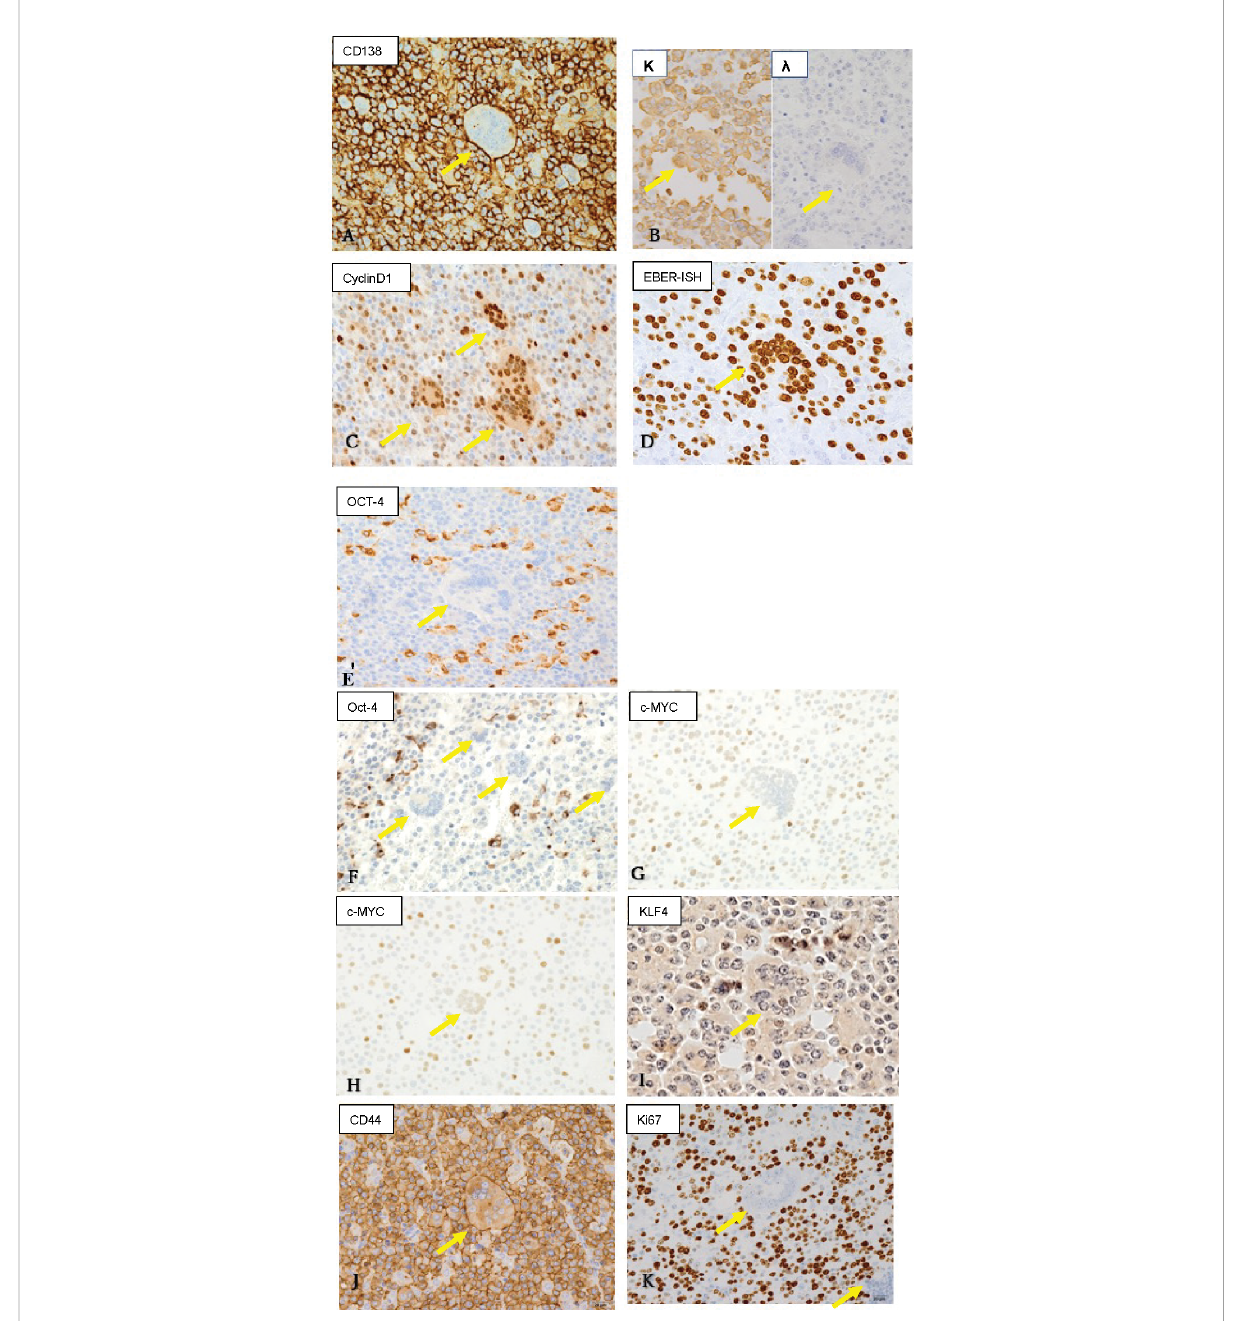
FIGURE 2 Immunohistochemistry and Epstein-Barr virus-encoded RNA (EBER) in-situ hybridization fi ndings (original magni fi cation ×40). Yellow arrows indicate multinucleated cells. Both multinucleated giant cells and mononuclear cells were positive for (A) CD138 (a plasma cell marker; membranous positive), (B) light chain restriction of k > l (suggesting monoclonality), (C) cyclin D1 (a marker for plasma cell myeloma), and (D) EBER (suggesting Epstein-Barr virus-associated neoplasm). (E) Both cell types were negative for CD68 (a histiocyte marker). (F) Mononuclear cells were positive, but multinuclear giant cells were negative for OCT4 (Yamanaka factor). (G, H) c-Myc (Yamanaka factor) expression was stronger in mononuclear than in multinucleated cells, and multinucleated cells with a larger number of nuclei (G) showed weaker positivity than those with a smaller number of nuclei (H) . (I) KLF4 (Yamanaka factor) was positive in some of the mononuclear cells, but negative in the multinucleated giant cells. (J) CD44 (a marker for cancer stem cells) was positive in both cell types. (K) Mib1/Ki67 showed strong positivity in the mononuclear cells, while the multinucleated cells were almost